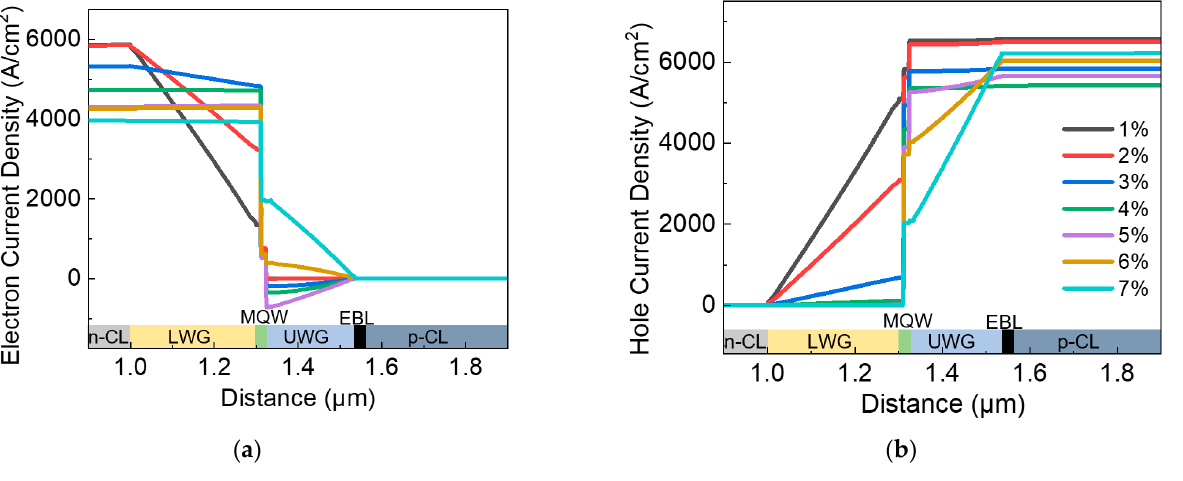
Figure 4. ( a ) Electron current density distribution and ( b ) hole current density distribution at the middle axis of device under the same injection current of 1000 mA.